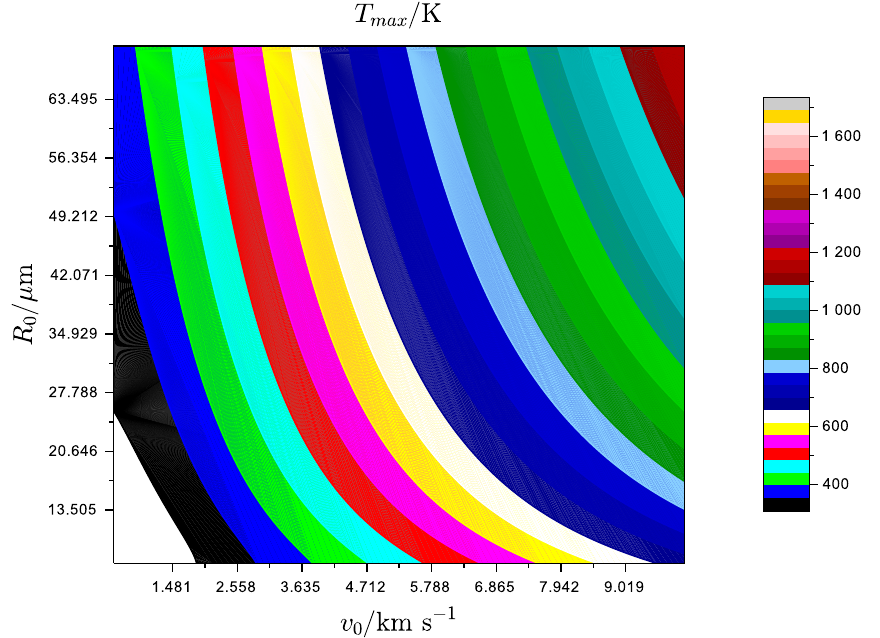
Figure 3. Contour lines of the maximum temperature during atmospheric entry versus the initial velocity and radius of micrometeoroids with 0.5 ≤ v 0 ≤ 10.0 km s − 1 and 7 ≤ R 0 ≤ 70 µ m (437.8 ≤ T max ≤ 1471.9